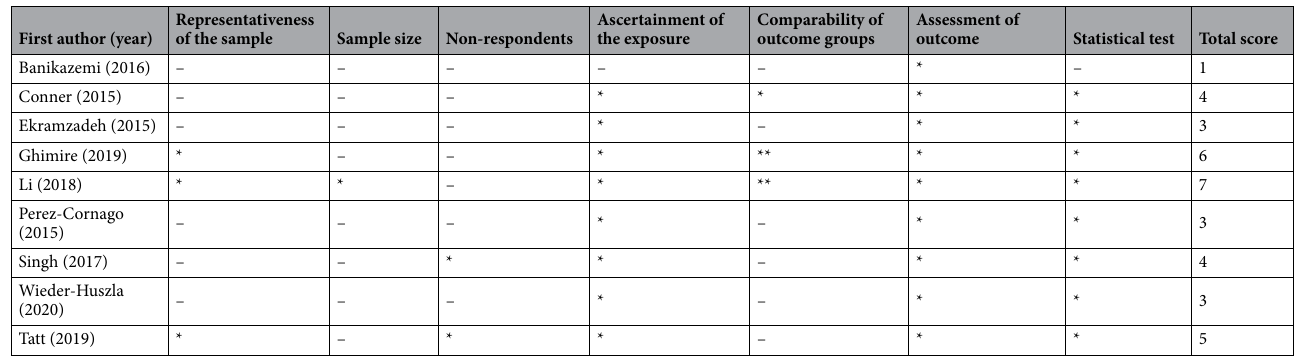
Table 5. Quality assessment of the included cross-sectional studies according to the Newcastle–Ottawa